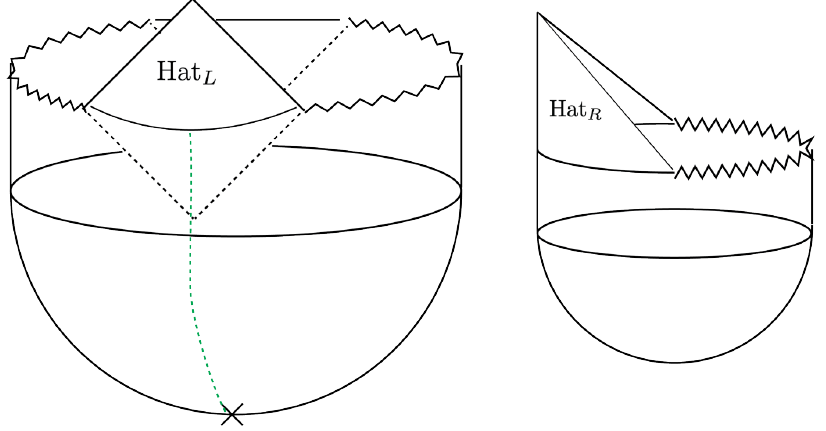
Figure 8. If we insert a conical singularity at a position which references only one of the hats, instead of both simultaneously, the dominant saddle will be two disconnected universes illustrated here. If we define the conical singularity with respect to the Hat L , then Hat L will be in a universe with angle 4 π and another, fluctuating asymptotically inflating region. Hat R will be off in its own 2 π universe. We have schematically illustrated the procedure of tying the conical singularity to a hat by the green dashed line. To prevent the saddle illustrated here from dominating the path integral, we need to tie the position of the conical singularity to both hats simultaneously. We discuss some ways of doing this in the main